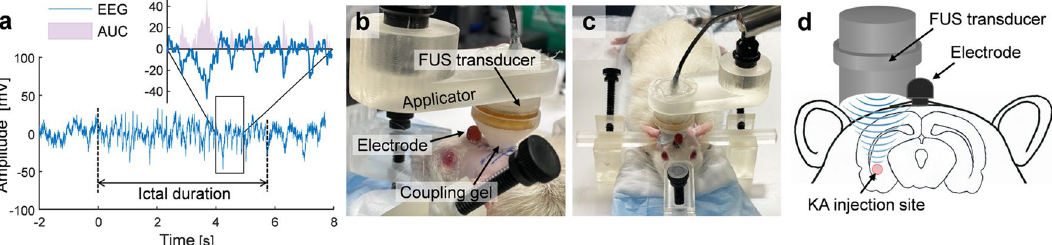
Figure 2. An exemplar ictal EEG segment and the transcranial FUS sonication setup. ( a ) Illustration of the derivation of ictal duration and ictal amplitude from an exemplar EEG segment. The dotted lines indicate the beginning and end points of the ictal event with repetitive sharp EEG waves, defining the ictal duration. The ictal amplitude was derived as the area under the curve of the absolute values of EEG signals (AUC, in pink) divided by the ictal duration. Inset: a magnified view of the selected square area. ( b–d ) Transcranial FUS sonication setup viewed from the ( b ) left behind and ( c ) front of the mTLE rat. The FUS transducer connected to a swivel/lockable applicator was stereotactically placed over the head, posterior to the implanted electrode head pedestal, for the sonication targeting to the KA injection site. An acoustic coupling gel was inserted between the transducer and scalp. ( d ) Illustration of FUS sonication delivery to the KA injection